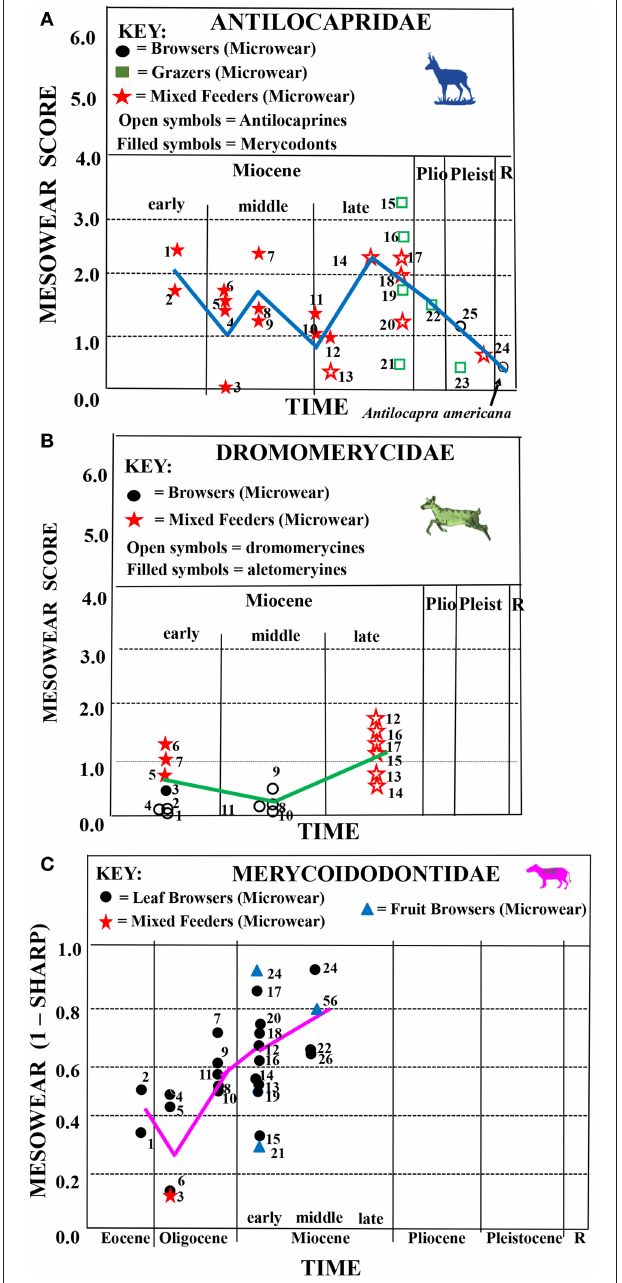
FIGURE 5 | Synthesis of mesowear and microscopic microwear results for fossil antilocaprids, dromomerycids and merycoidodontids plotted along a time axis. (A) Antilocaprids: average mesowear scores for each taxon are shown plotted along a horizontal axis representing geological time. Symbols used for each mesowear score represent dietary assignment assessed via microwear (microwear and mesowear data from Semprebon and Rivals, 2007). Key for microwear dietary assignment: circles = browsers, squares = grazers, stars = seasonal or regional mixed feeders. Blue trend line = mesowear trend line using the same taxa from the same localities that had both mesowear and microwear data available ( N = 26). Key: “Merycodontinae” − 1 = Paracosoryx dawesensis , 2 = Paracosoryx wilsoni , 3, 4 = Merriamoceros coronatus, (Continued)